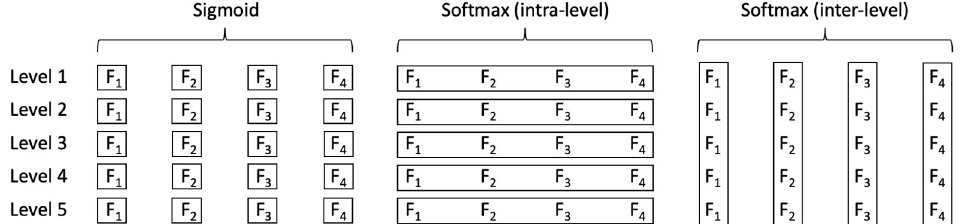
Figure A8. Illustration of the activations for the latent representation of five levels. Boxes indicate dependence; for the sigmoid activations, each feature F i can take any value between 0 and 1, inde- pendent of other features Fj , i (cid:54) = j ; for softmax activations, the values of the features in each box are normalized to 1 so that ∑ F i = 1.